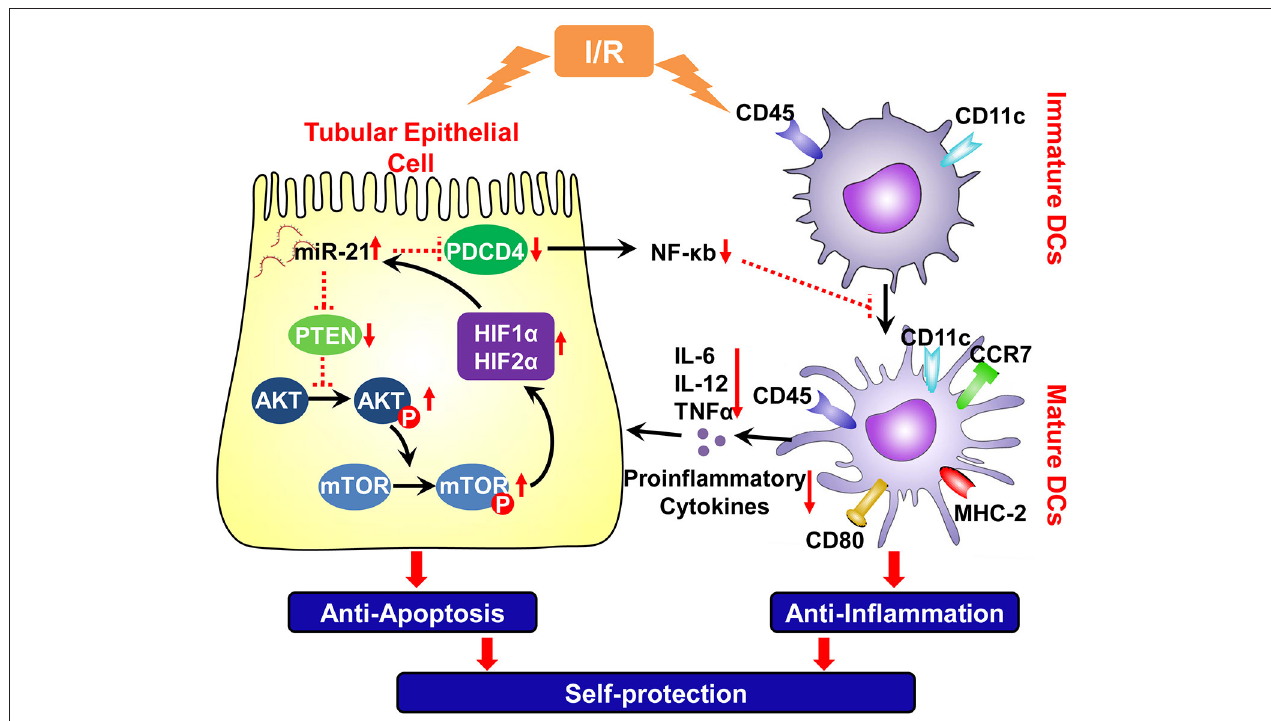
FIGURE 8 | Schema of IR induced miR-21 on the renal self-protection and the involved underlying mechanism. Ischemia/reperfusion elevated expression of miR-21 in the tubular epithelial cells, which prevent kidney injury by resisting apoptosis of epithelial cells directly and by inhibiting inflammatory reaction evoked by mature DCs. A positive feedback loop between miR-21 and HIF-1 α /2 α was mediated by PTEN/Akt/mTOR pathway, which is involved in the reduction of epithelial apoptosis induced by ischemia/reperfusion. Upon injury of epithelium, ischemia/reperfusion also triggers inflammation by inducing maturation of DCs. Up-regulation of miR-21 also down-regulates the PDCD4 and then NF- κ B that is an important factor to promote the maturation of dendritic cells. Thus, IR induced miR-21 contributes to anti-inflammatory reaction and renoprotection by inhibiting maturation of DCs. PTEN, tensin homolog deleted on chromosome 10; PDCD4, proapoptotic target effectors programmed cell death protein 4; Akt, protein kinase B; p-Akt, phospho-Akt; mTOR, mammalian target of rapamycin; p-mTOR, phospho- mTOR; HIF, hypoxia-inducible factor; CCR-7, chechemokinereceptor7; NF- κ B, nuclear factor-k-gene binding k; TNF- α , Tumor Necrosis Factor-alpha. Red vertical arrows: “ ↓ ” means decrease, “ ↑ ” means increase. The red dotted line means inhibiting